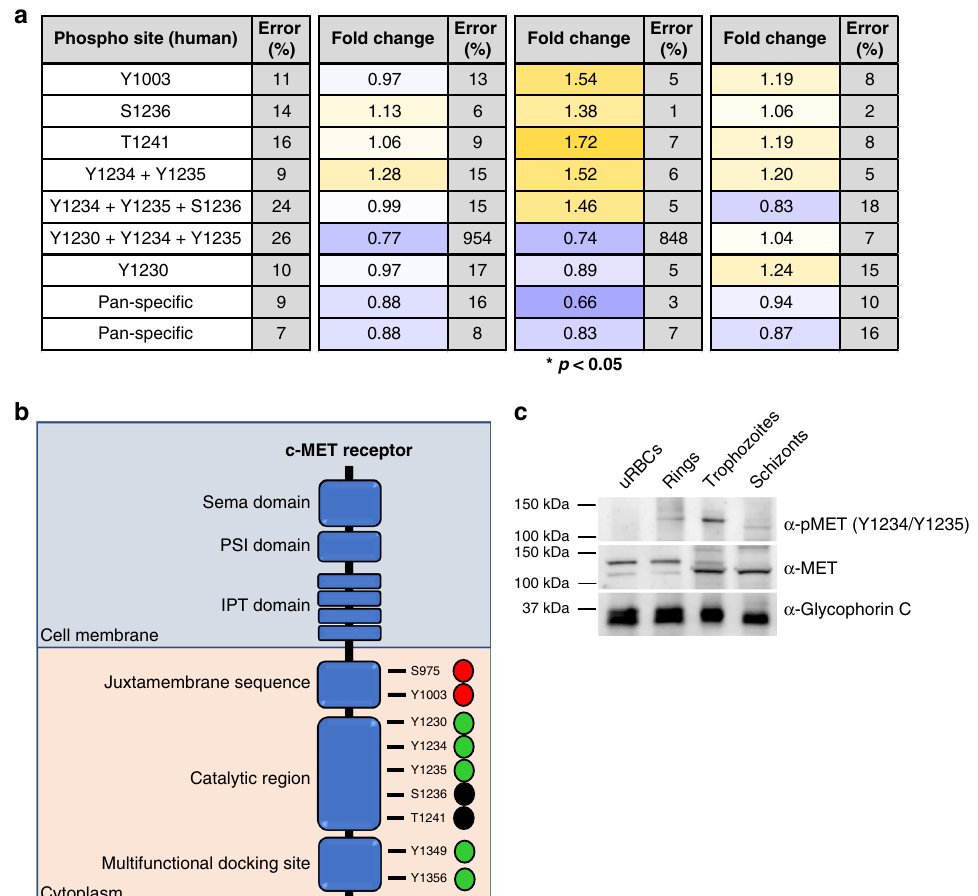
Fig. 5 Activation of c-MET in infected erythrocytes. a c-MET phosphorylation sites covered by the antibody microarray, with the fold change from uRBC control values for the three time points (ring, trophozoite and schizont). Signals that were signi fi cantly different during infection are marked by an asterisks ( p < 0.05, unpaired two-tailed T -test). b Schematic of the c-MET protein. The juxtamembrane sequence contains both S975 and Y1003, which represent c- CBL-binding sites that target the receptor for degradation (red circles) 73,74 . The catalytic domain contains Y1230, Y1234, Y1235, S1236 and T1241. All activating tyrosine phosphorylations (green circles) occur through receptor homodimerization 42,45,75 . The function of S1236 and T1241 (black circles) is uncharacterized. The multifunctional docking site contains two phosphosites, Y1349 and Y1356, which aid in the binding of adapter molecules such as grb2 and GAB1 45 . c Western blotting validation of c-MET phosphorylation across asexual development. A phospho-speci fi c antibody to c-MET (Y1234 + Y1235) detected phosphorylated c-MET at the ring and trophozoite stages (upper panel), n = 2 independent experiments. A pan c-MET antibody detected c-MET across all four samples, with a double band in the uninfected, ring and trophozoite samples (middle panel). An antibody against Glycophorin-C was used as a loading control (lower panel). Source data are provided as a Source Data fi